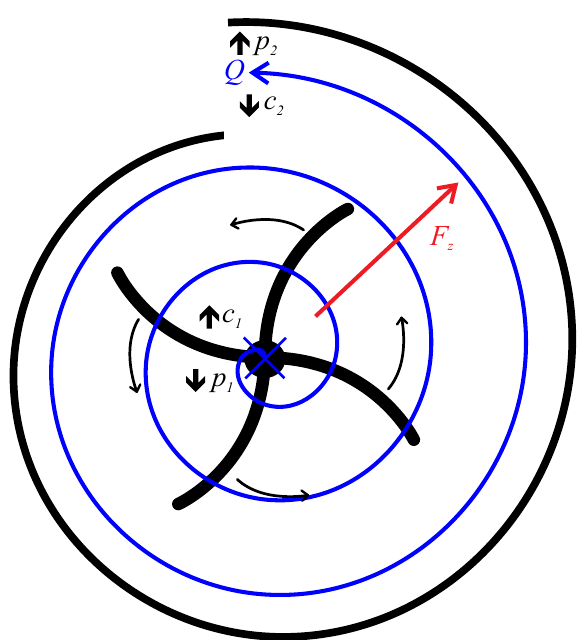
Figure 1. Centrifugal pumping principle with fluid flow Q (blue arrow) coming from top, rotated by impeller (black) and pushed outwards due to centrifugal force F z (red) into spiral shape of pump chamber, creating a pressure gradient from inlet to outlet p 2 > p 1